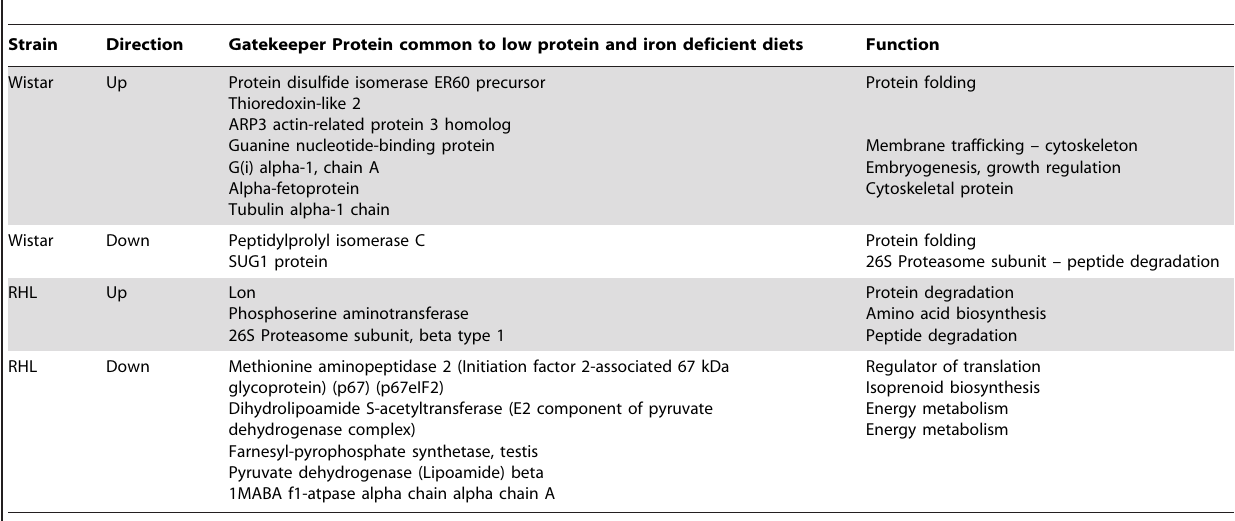
Table 6. Proteins identified by mass spectrometry following 2D gel electrophoresis.